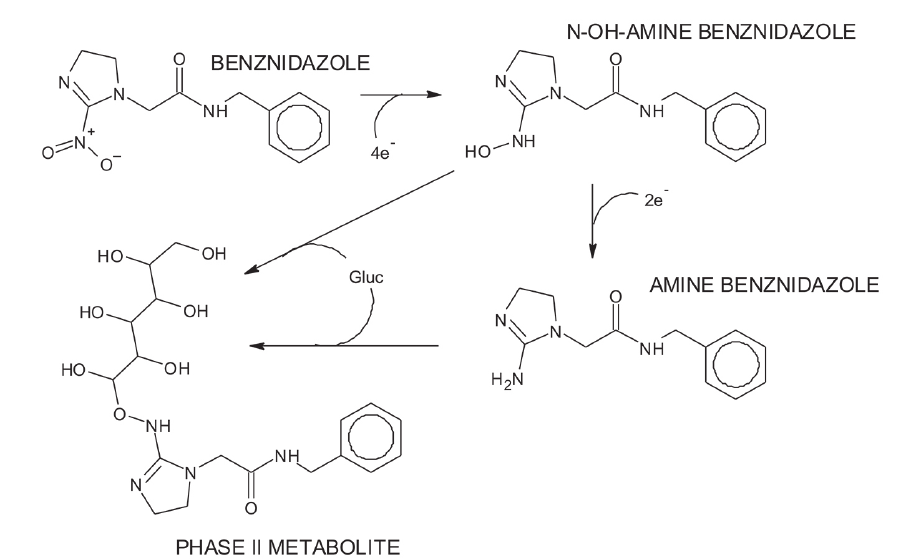
FIGURE 3 - Proposed metabolic pathway of BZN and its metabolites